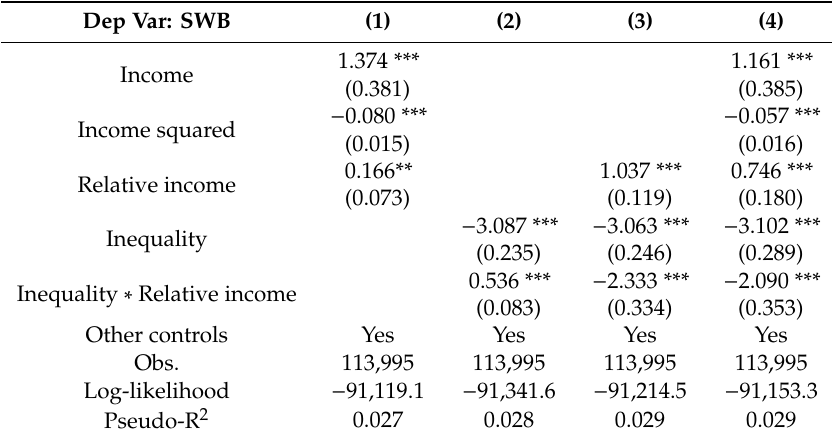
Table 8. Social comparison concerns as a